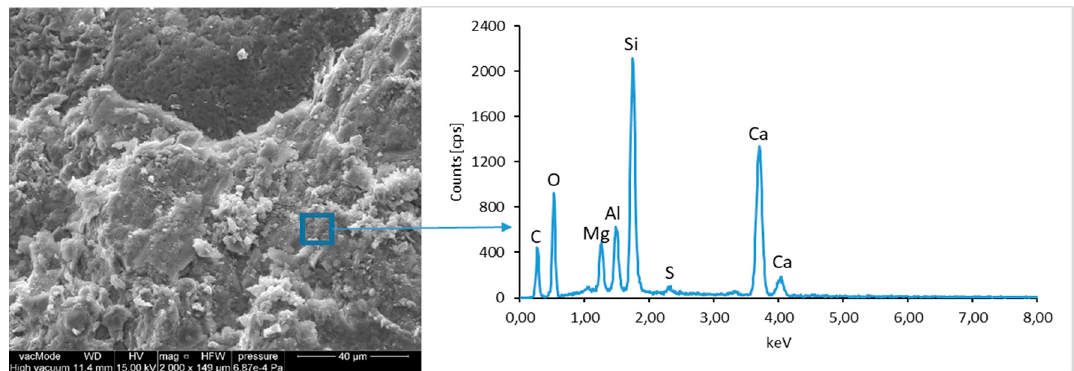
Figure 11. SEM micro-structure of CII.0 concrete and results of elemental analysis in EDS micro- area—compact clusters of C–S–H phase particles can be seen.